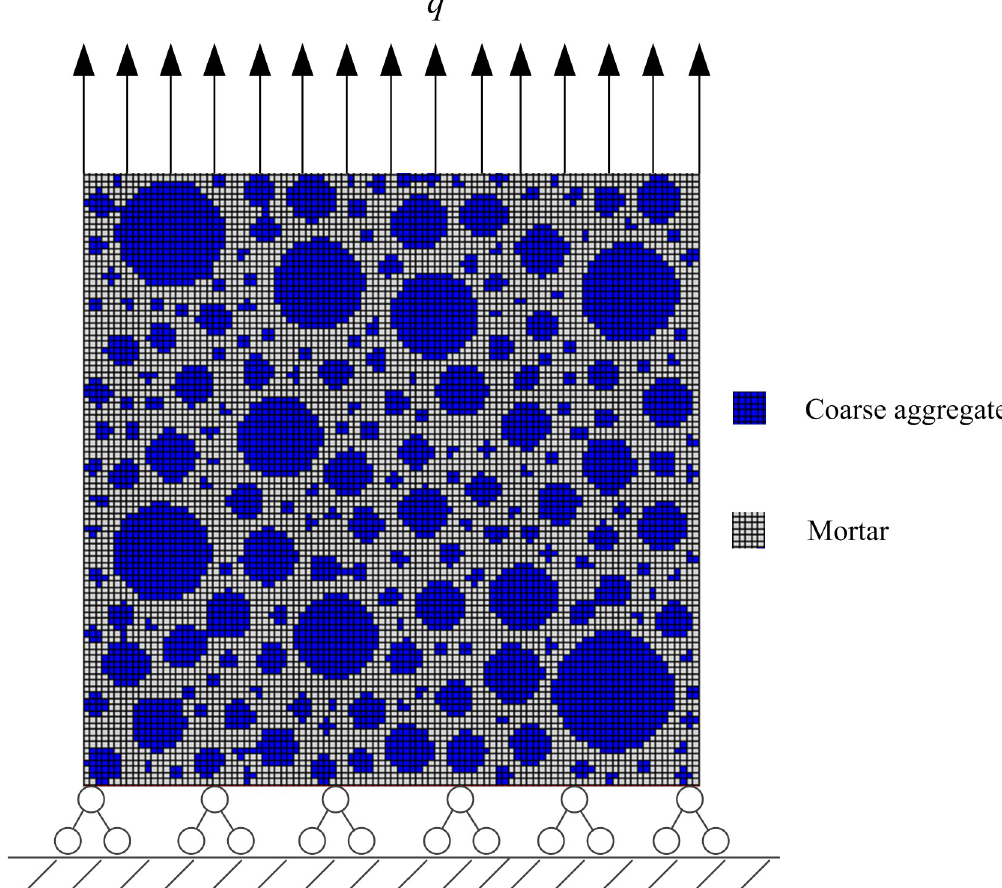
Fig 9. Constraints and the load of the concrete specimen. The dimension of the specimen is 100mm × 100mm, and the mesh size is 1mm × 1mm. The top of the concrete block is uniformly loaded, the bottom is fixed and the lateral sides are free. In uniaxial tensile process, the pressure q is positive, while in uniaxial compressive process, q is negative.